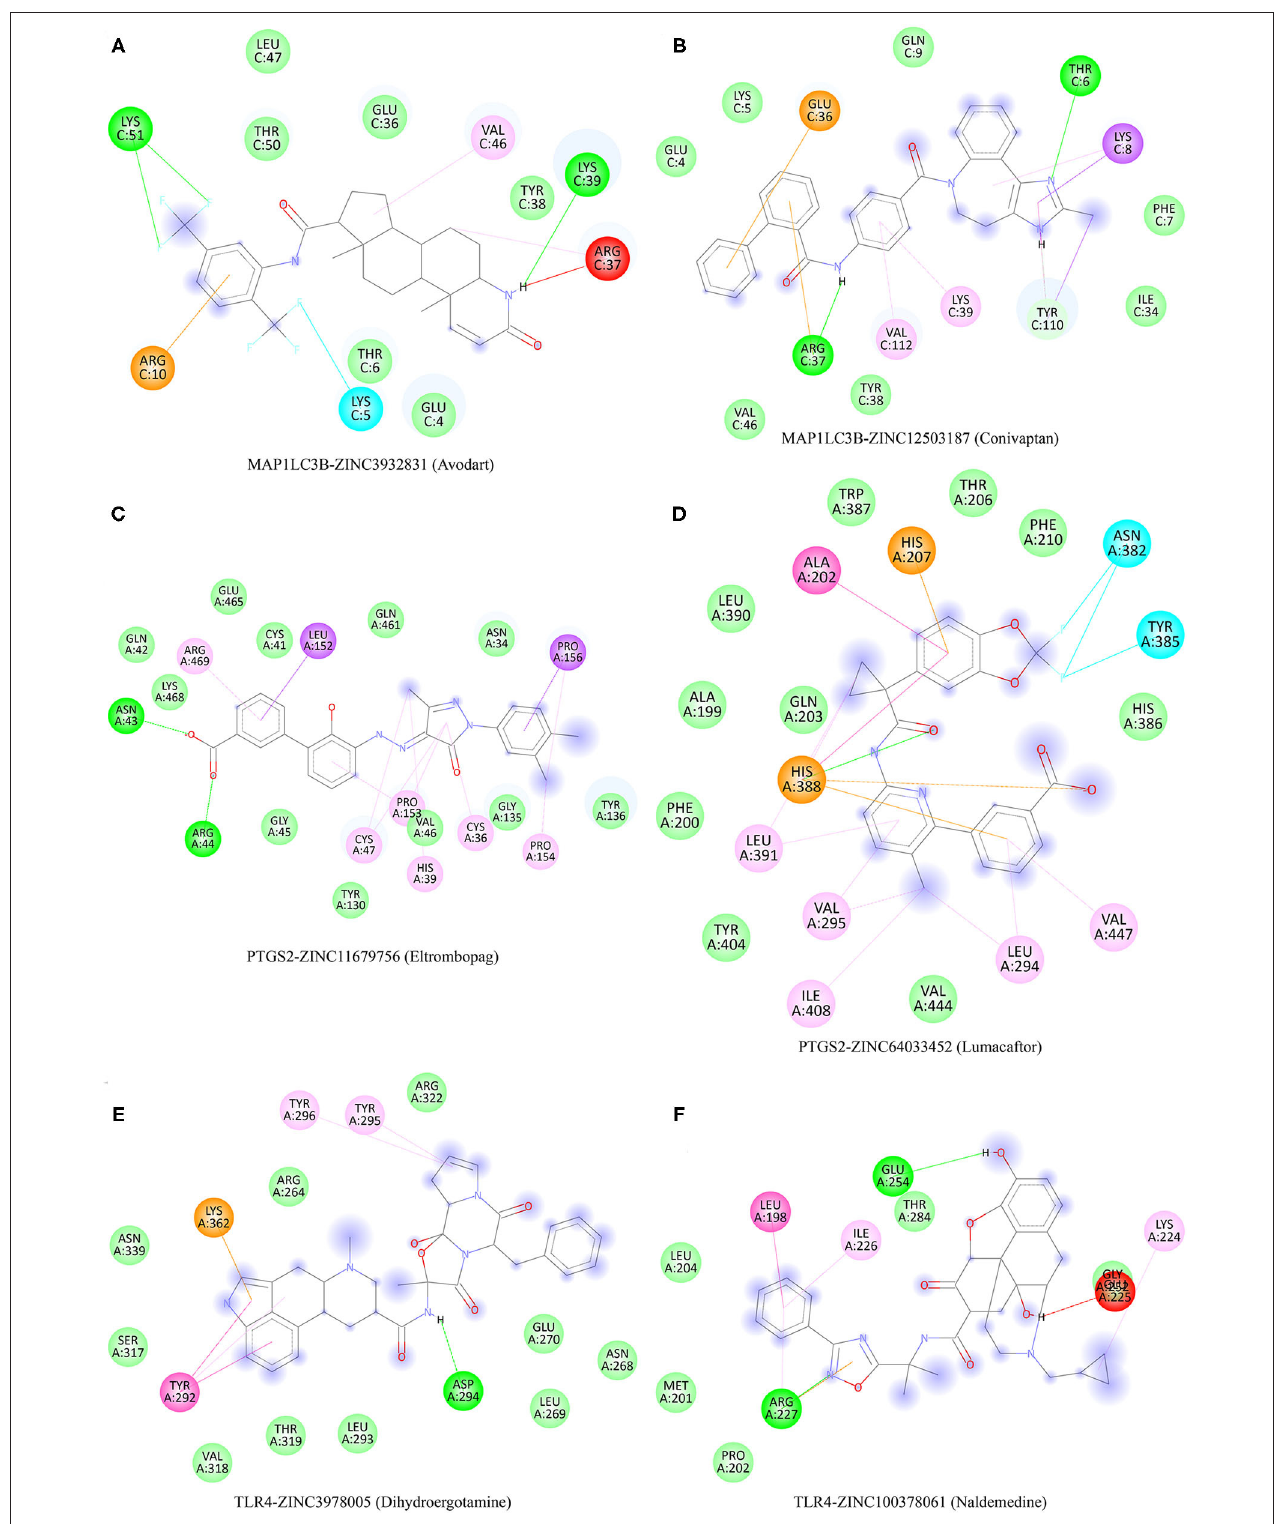
FIGURE 9 | Potential therapeutic compounds corresponding to ferroptosis-related biomarkers for ischemic stroke. (A,B) Potential therapeutic compounds corresponding to MAP1LC3B for ischemic stroke. (C,D) Potential therapeutic compounds corresponding to PTGS2 for ischemic stroke. (E,F) Potential therapeutic compounds corresponding to TLR4 for ischemic